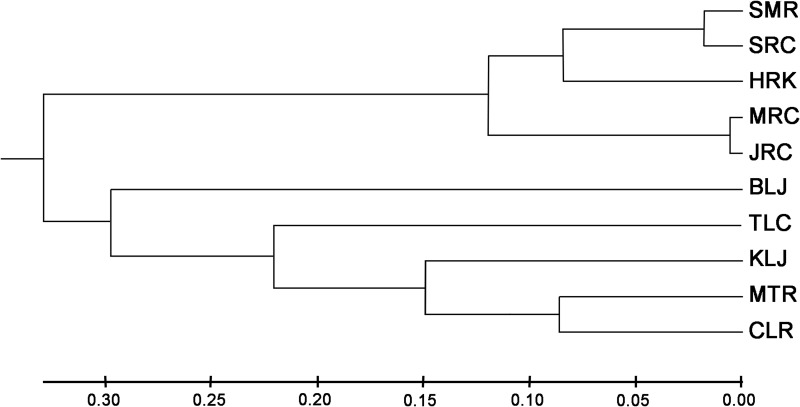
UPGMA tree showing relationships among the 10 sampling sites.